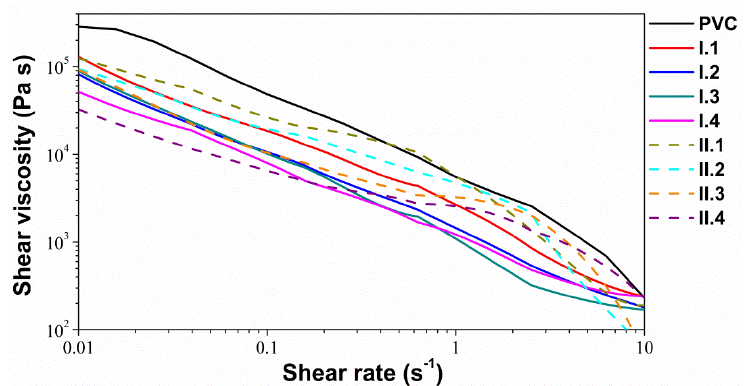
Figure 14. Shear viscosity of PVC and the PVC composites.